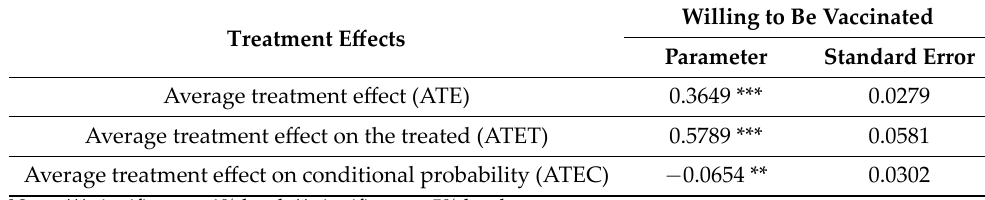
Table 5. Treatment effects of health insurance on vaccination